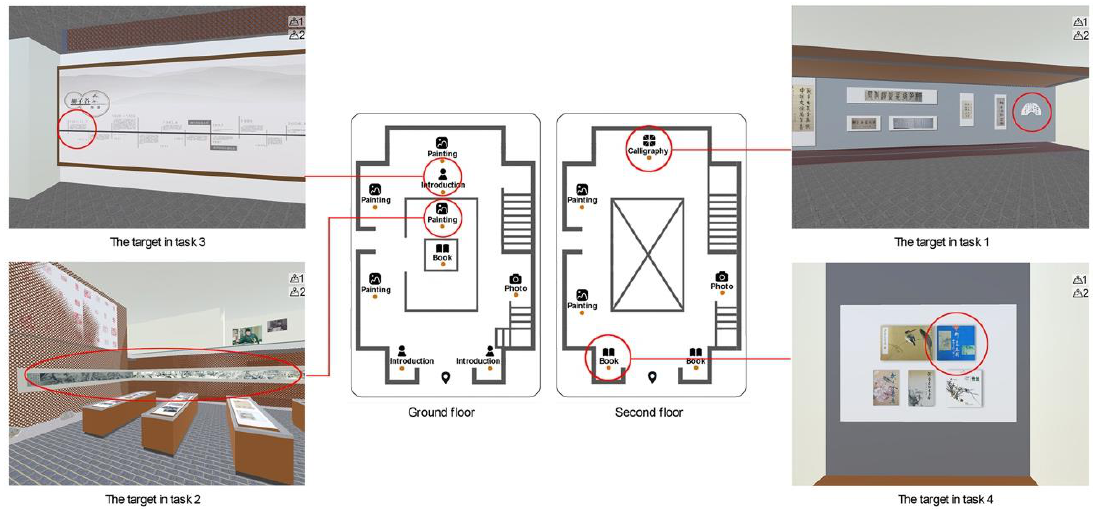
Figure 4. Four spatial perception tasks in this study.